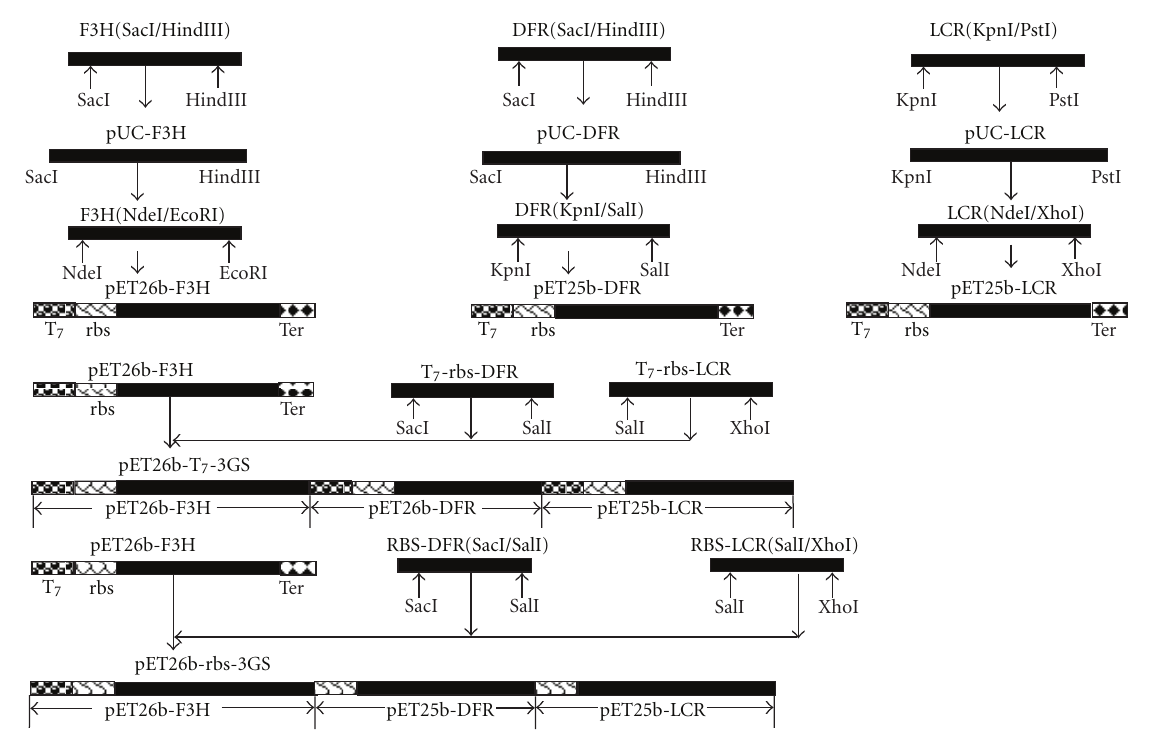
Figure 2: Diagrammatic presentation of the